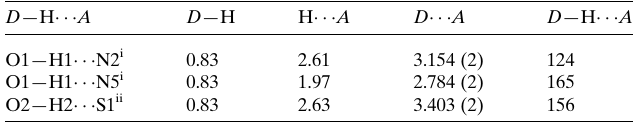
Table 1 Hydrogen-bond geometry (A˚ , (cid:4)